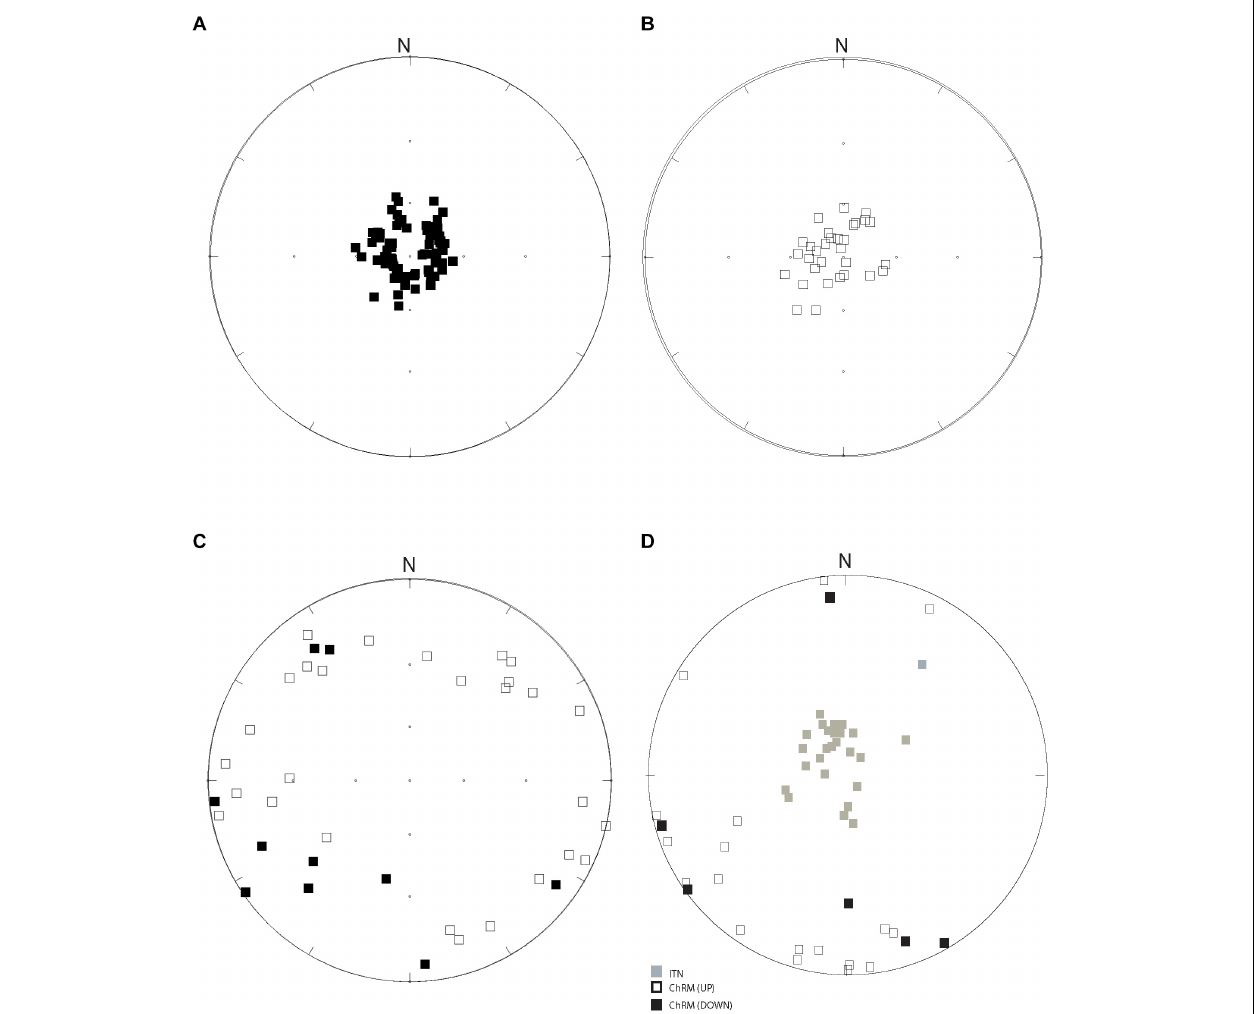
FIGURE 5 | Equal area projections of component (specimen) directions from DB and EC. (A) Equal area projection of ITN from DB. (B) Equal area projection of ITR from DB. (C) Equal area projection of the ChRM from DB. (D) Equal area projection of the ITN and ChRM from EC (squares ChRM; shaded squares ITN). The closed squares indicate down directions and open squares indicate up directions. N,